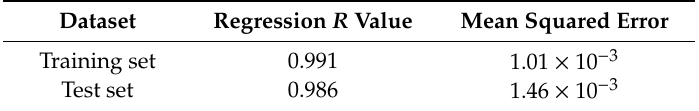
Table 2. Simulation model performance (the values refer to dimensionless